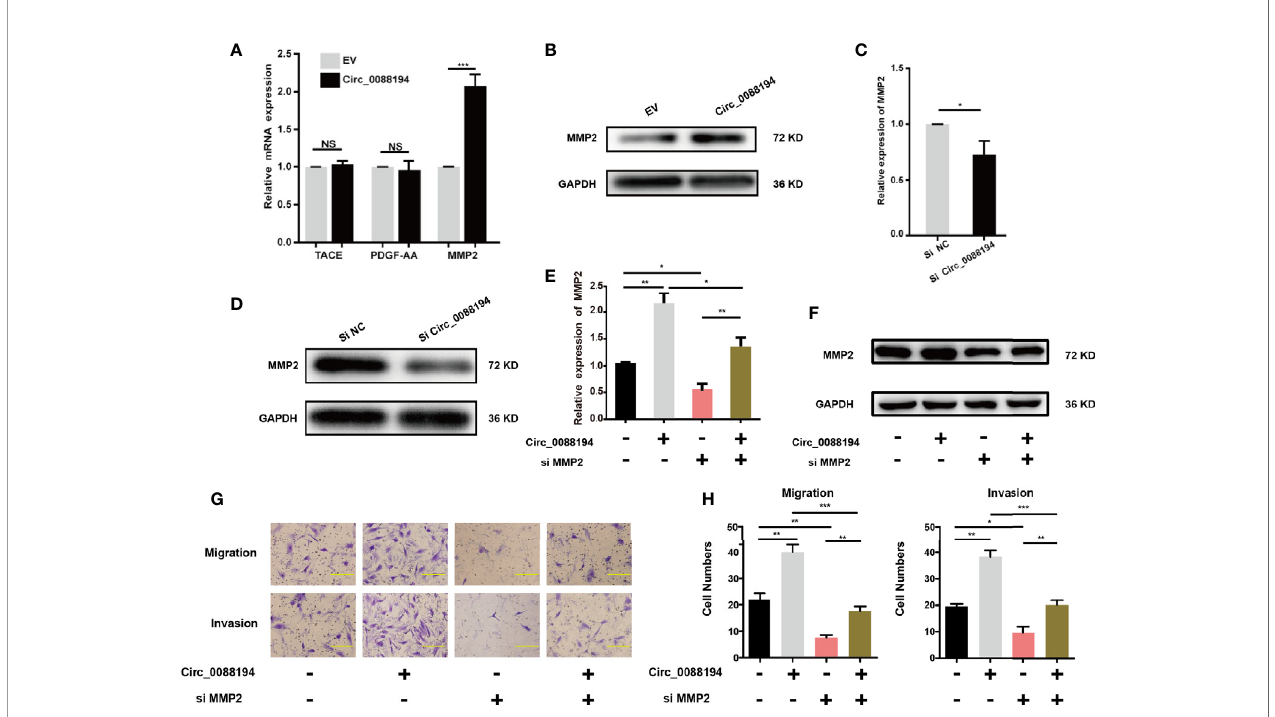
FIGURE 3 | MMP2 expression in RA-FLSs is regulated by Circ_0088194. (A) Adenovirus expressing Circ_0088194 or empty vector (EV) were transfected into RA-FLSs. QRT-PCR determined tumor necrosis factor- a converting enzyme ( TACE ), platelet derived growth factor subunit AA ( PDGF - AA ), and matrix metalloproteinase 2 ( MMP2 ) mRNA levels. (B) Adenovirus expressing Circ_0088194 or EV were transfected into RA-FLSs. Western blotting was used to detect MMP2 expression. (C, D) The MMP2 mRNA and protein expression levels were examined in RA-FLSs transfected with Circ_0088194#1 siRNAs or the negative control (NC). (E, F) Western blotting and qRT- PCR detection of MMP2 expression. RA-FLSs were co-transfected with the adenovirus expressing Circ_0088194 or MMP2 siRNA. (G, H) Transwell migration and Matrigel invasion assays were used to evaluate the migratory and invasive activity of RA-FLSs. Adenovirus expressing Circ_0088194 or MMP2 siRNA were co-transfected into RA-FLSs. Scale bar, 500 µm. Data are shown as mean ± SD. NS, not signi fi cant. *indicates p < 0.05, **indicates p < 0.01, and ***indicates p <